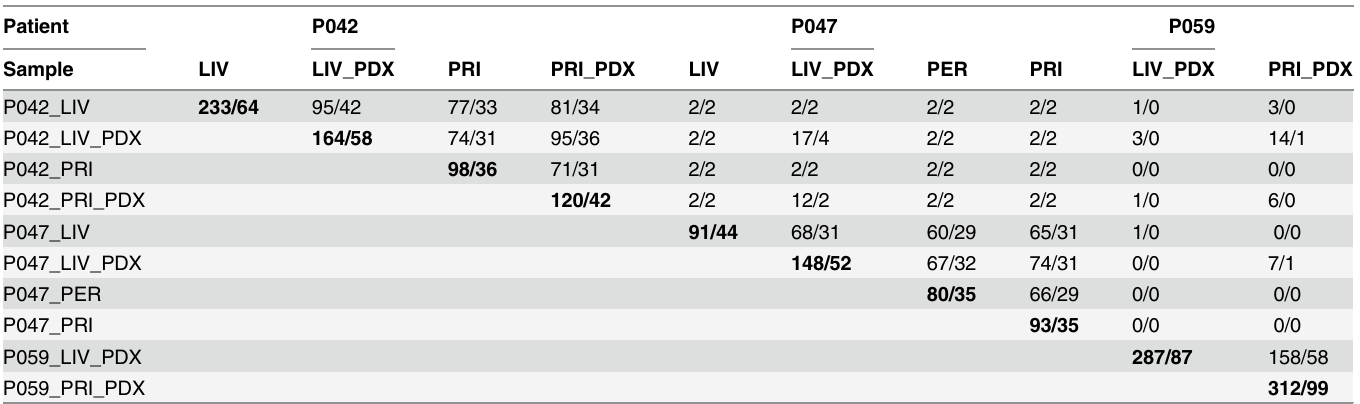
Table 3. Pairwise comparison matrix for common somatic SNVs across all